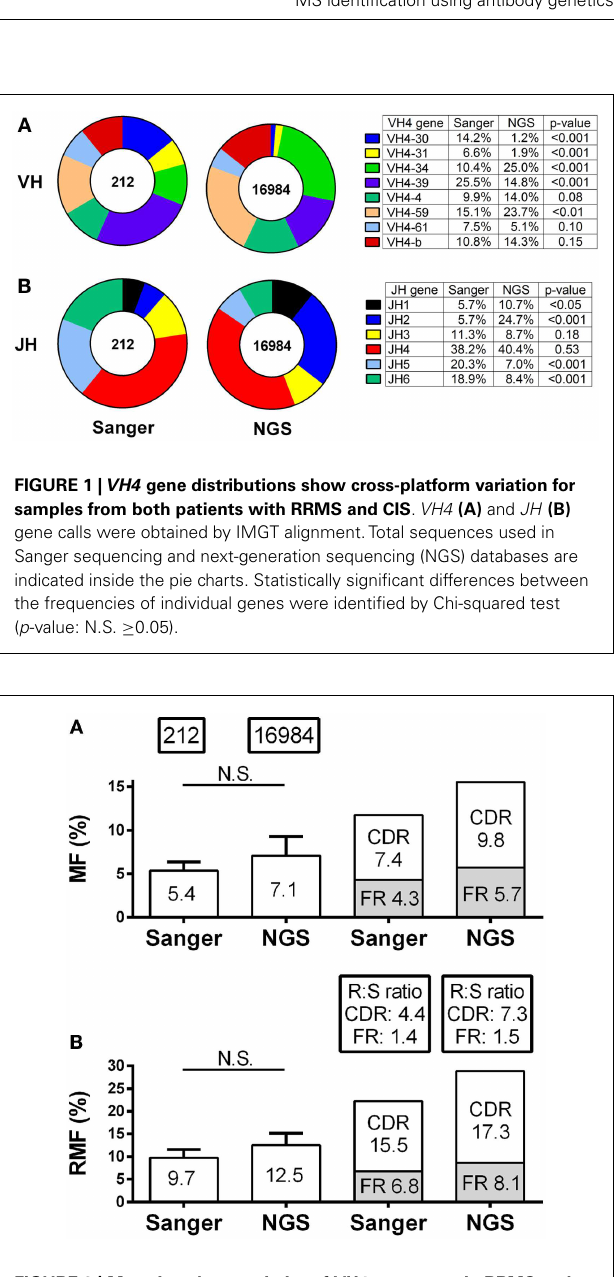
FIGURE 2 | Mutation characteristics of VH4 sequences in RRMS and CIS patients are shown . Sanger sequence data include 212 sequences with 2265 total point mutations and 1386 total replacement mutations (RM). Next-generation sequencing (NGS) data include 16,984 unique sequences with 263,764 total point mutations and 154,457 total replacement mutations (RM). (A) Mutation frequency (MF) analysis was done by nucleotide; (B) replacement mutation frequencies (RMF) analysis was done by codon. MF and RMF were calculated by patient, and bar graphs show mean (indicated on the bar graphs) and S.D. (statistical significance of the distributions was tested for byWilcoxon matched-pairs signed rank test; N.S. ≥ 0.05). MF, RMF, and R:S ratios for CDR and FR regions were calculated independently by region for each patient and are shown as patient